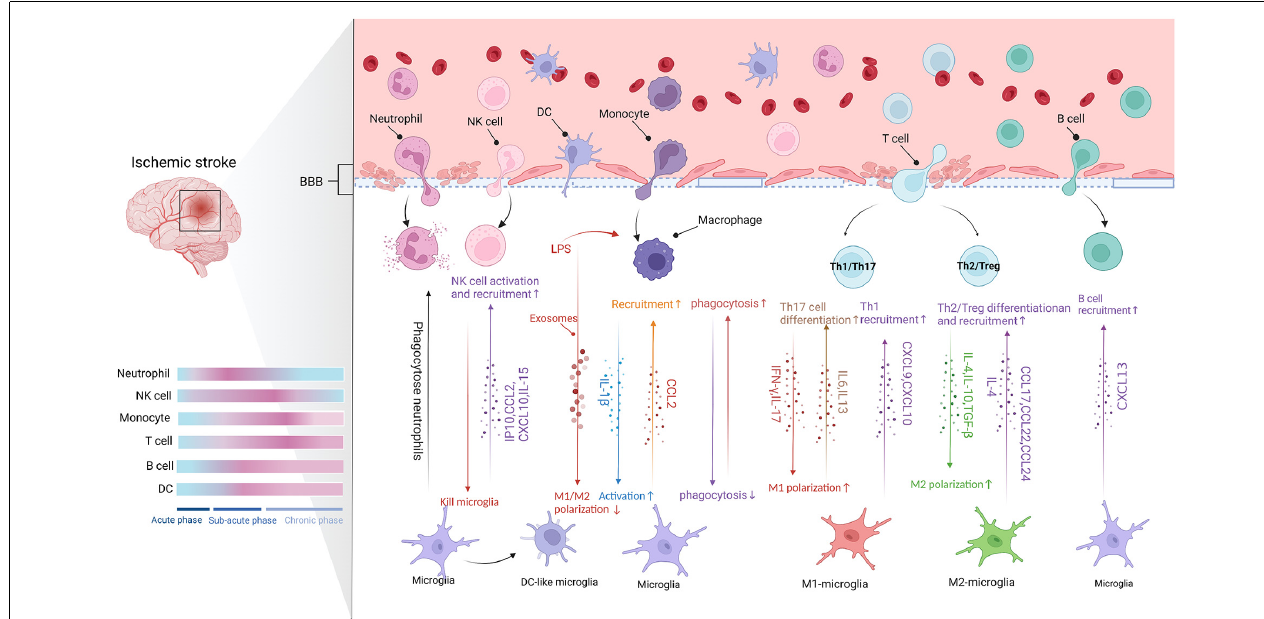
FIGURE 2 | The communication between microglia and CNS-infiltrating cells (Figure created with BioRender.com). Following BBB destruction, peripheral immune cells infiltrate into brain parenchyma and work with microglia to damage or protect the brain tissue. The migration of leukocytes to ischemic lesions presents a time scale and they act in different stages of stroke (Blue represents baseline conditions, whereas pink indicates peak modifications of the immune cells. Acute phase: up to 8 h after stroke. Subacute phase: 8–48 h after stroke. Chronic phase: over 48 h after stroke). Microglia release chemokines to promote the infiltration of peripheral immune cells. Moreover, different signals crosstalk between different subtypes of peripheral immune cells and different microglia phenotypes affect pro- or anti-inflammatory function.